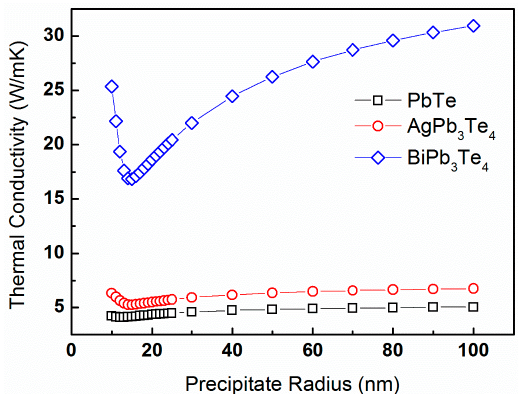
Figure 9. The lattice thermal conductivity of PbTe calculated from expression (16) for constant temperature of T = 300 K, precipitate volume fraction of v f = 5%, and ∆ R = 2 nm as a function of the average precipitate radius. The calculations are for the PbTe, AgPb 3 Te 4 , and BiPb 3 Te 4 compounds, denoted by black squares, red circles, and blue triangles, respectively.